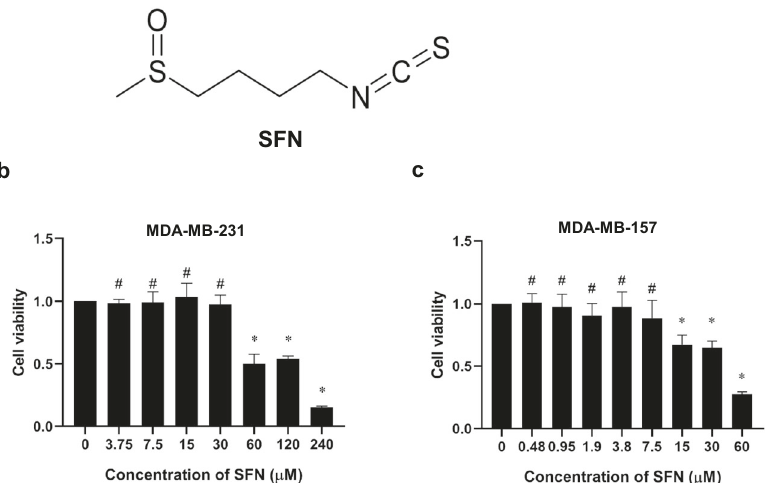
Fig. 1 The chemical structure of SFN and its effects on the viability of MDA-MB-231 and MDA-MB-157 cells. a The chemical structure of SFN. b Effects of SFN at different concentrations on the viability of MDA-MB-231 cells. Data shown are mean ± SEM. n = 5, * P < 0.05; # P > 0.05. c Effects of SFN at different concentrations on the viability of MDA-MB-157 cells. Data shown are mean ± SEM. n = 5, * P < 0.05; # P >